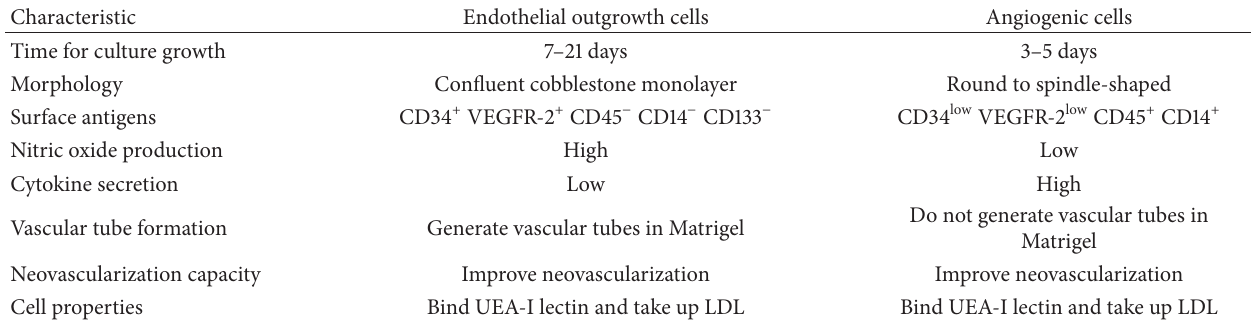
Table 1: Main characteristics distinguishing endothelial outgrowth cells and angiogenic cells.